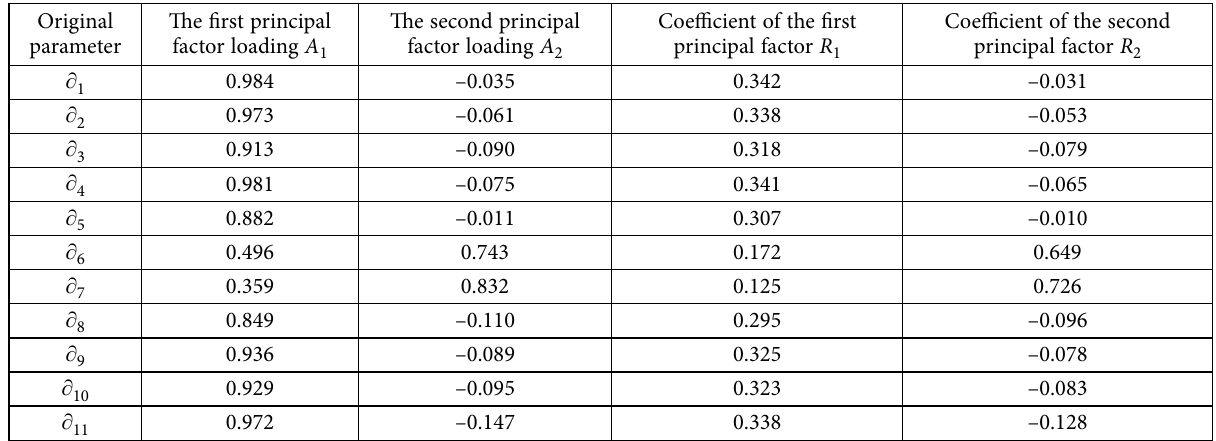
Table 2. The coefficient and load of principal factor